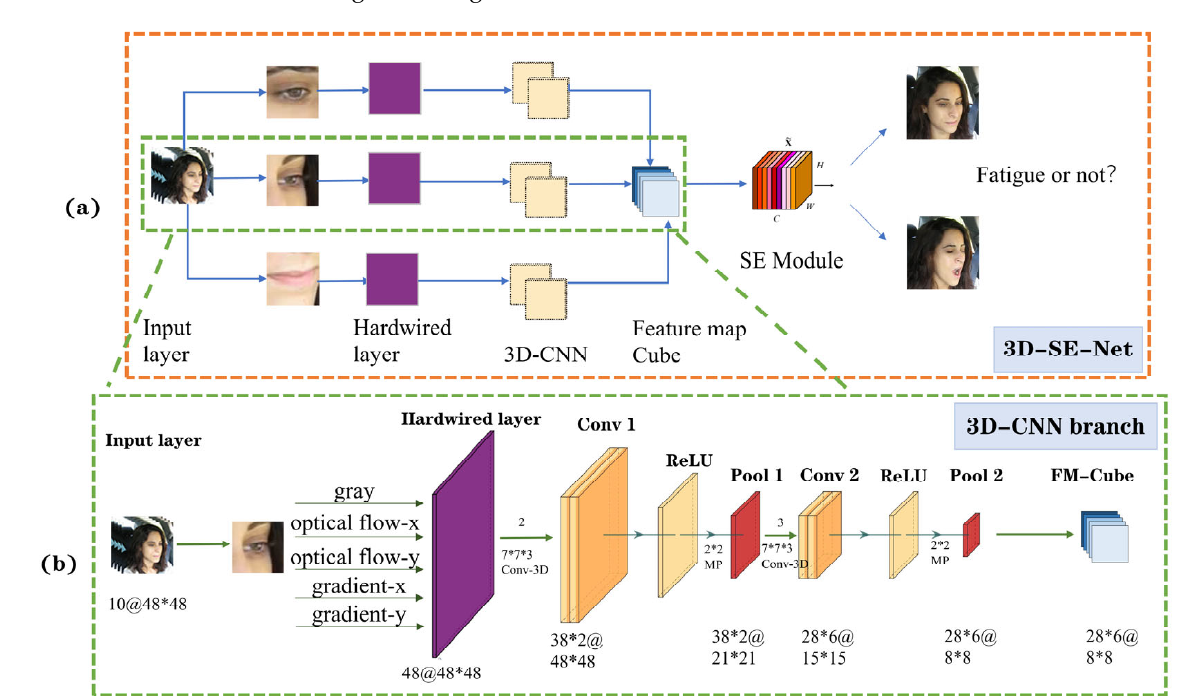
Figure 4. ( a ) The proposed 3D-SE-Net framework; ( b ) detailed diagram of the structure and parameters of the network layers.